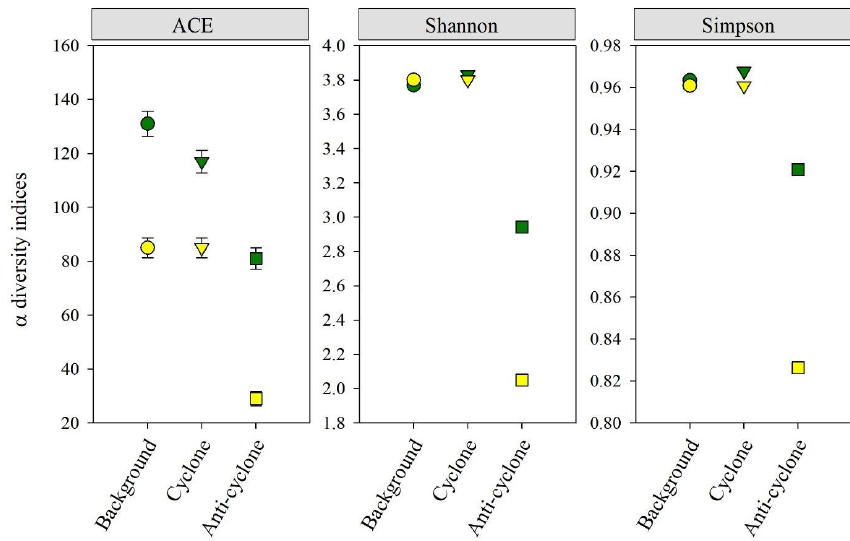
Figure 7. Zooplankton alpha diversity indices (ACE ± SE, Shannon, Simpson) based on 18S (green) and COI (yellow) amplicon sequencing in > 100µm samples collected from the upper 300m of cyclonic and anticyclonic eddies and at an uninfluenced background station in the southeastern Mediterranean Sea during October